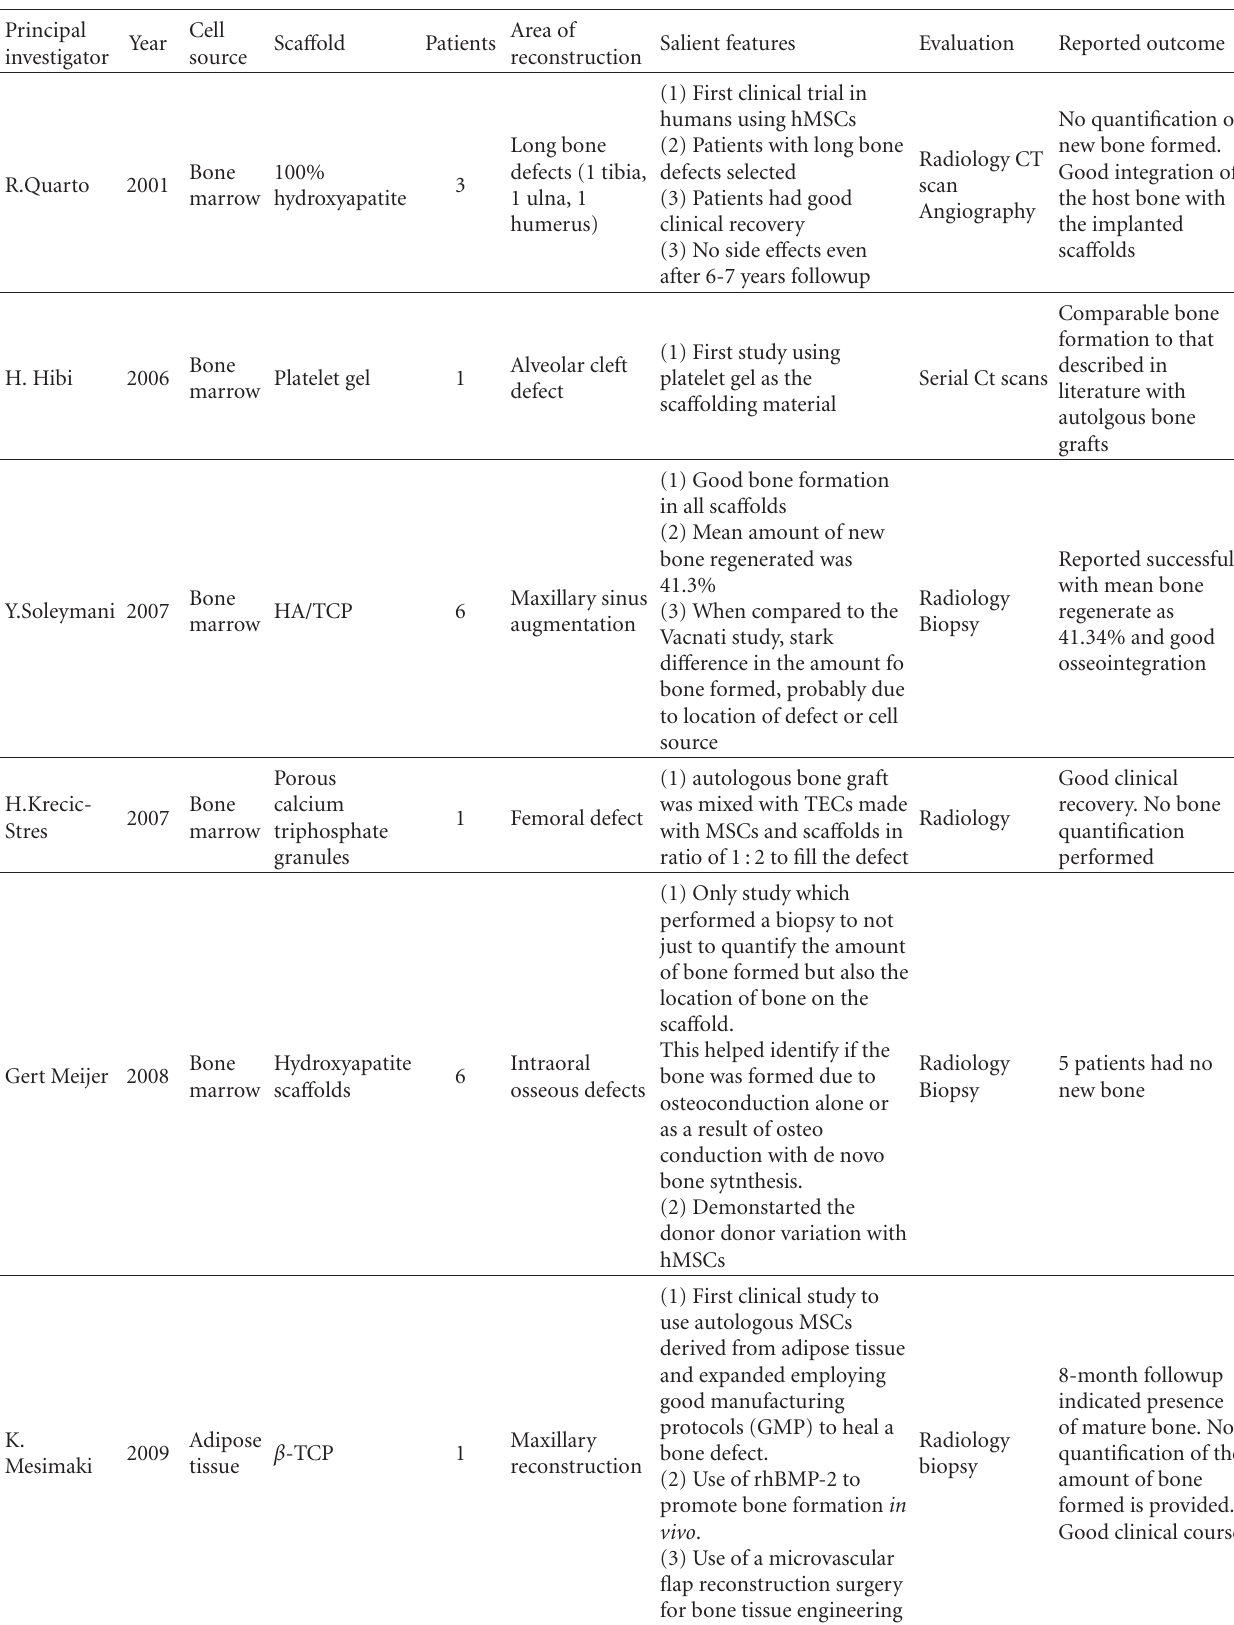
Table 1: Overview of the clinical studies performed on humans using-tissue engineered